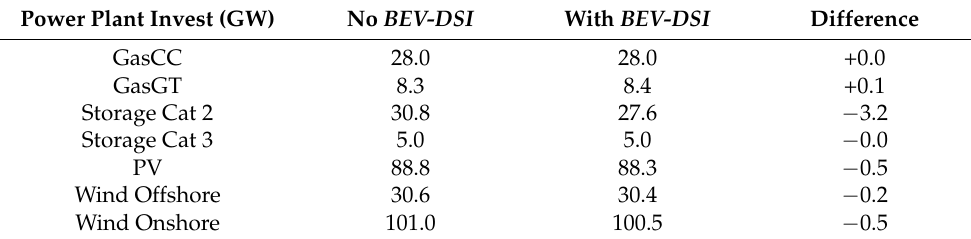
Table 4. Comparison of the resulting power plant investments for the scenario with and without the possibility for BEV-DSI